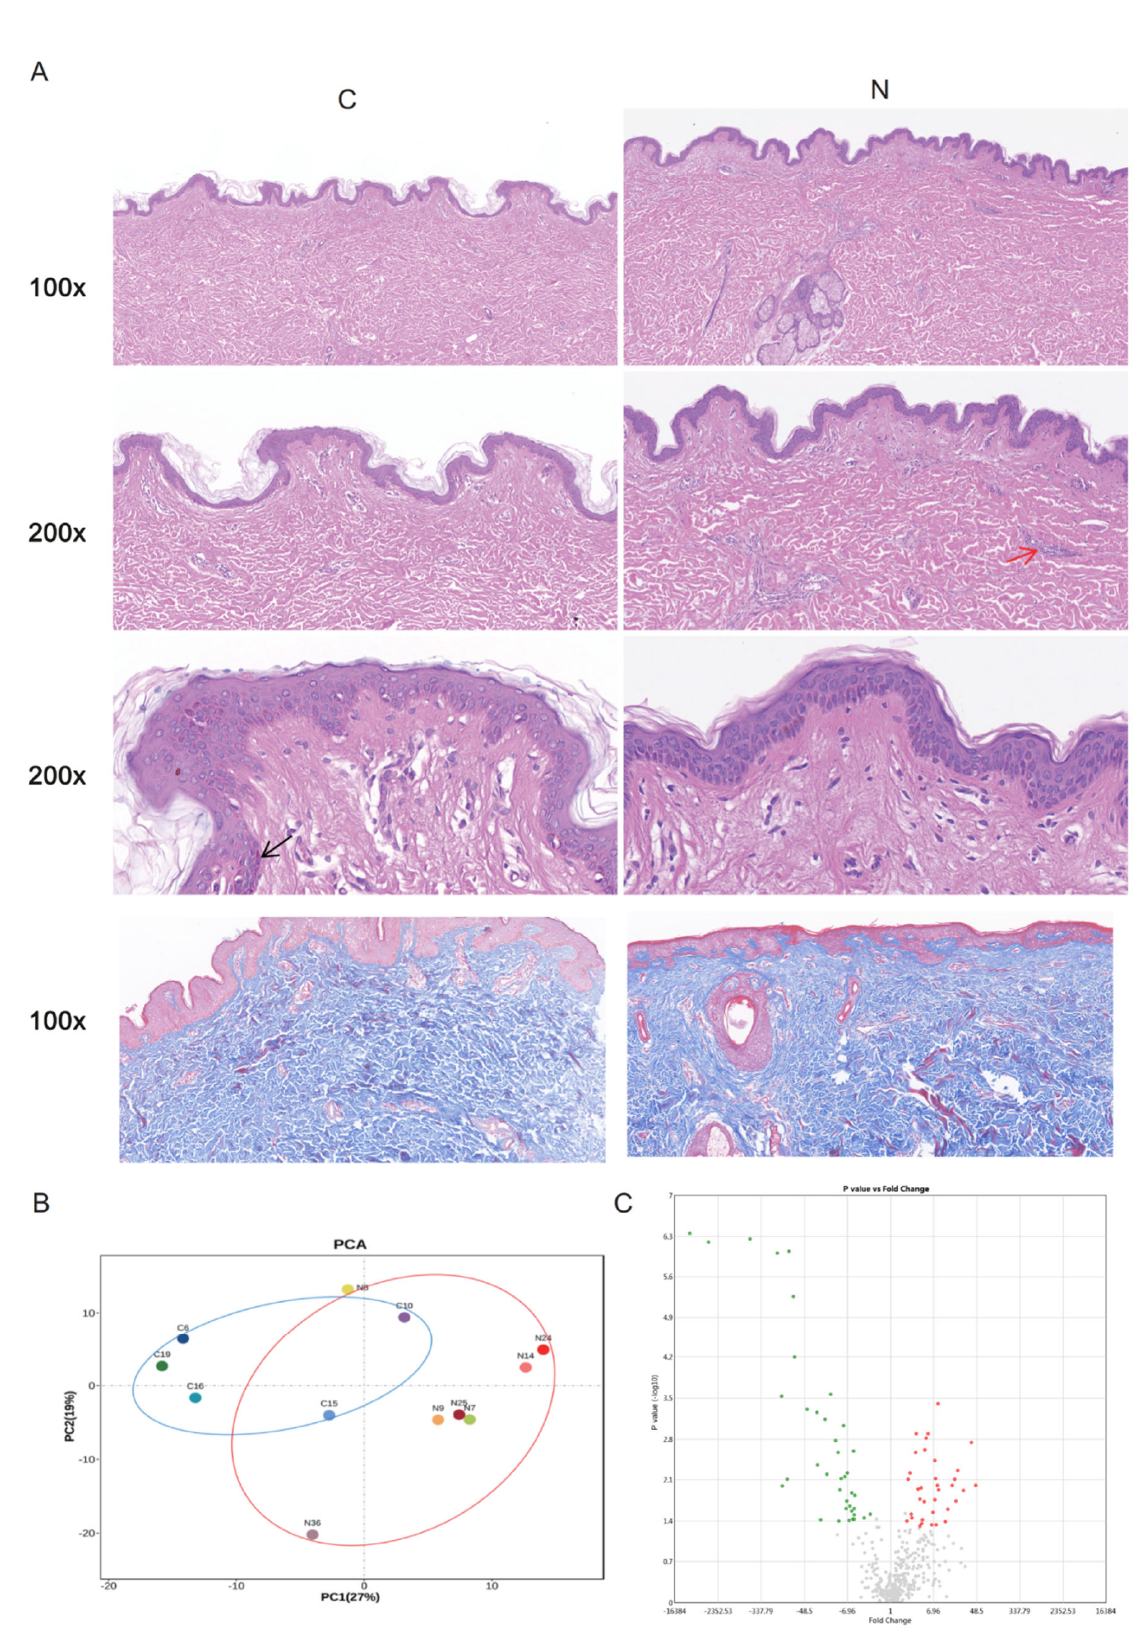
Figure 1. ( A ) Histological images of Group C and Group N, 100 × , 200 × , 400 × , black arrow, pigment deposition; red arrow, microvessel. Masson stain, 100 × . ( B ) Unsupervised principal component analysis (PCA) of Group C and Group N. Each point in the figure represents a sample, and the position of the point in the figure is determined by all the metabolites in the sample. The ellipse in the figure is based on the 95% confidence interval calculated and drawn by Hotelling T2. The sample